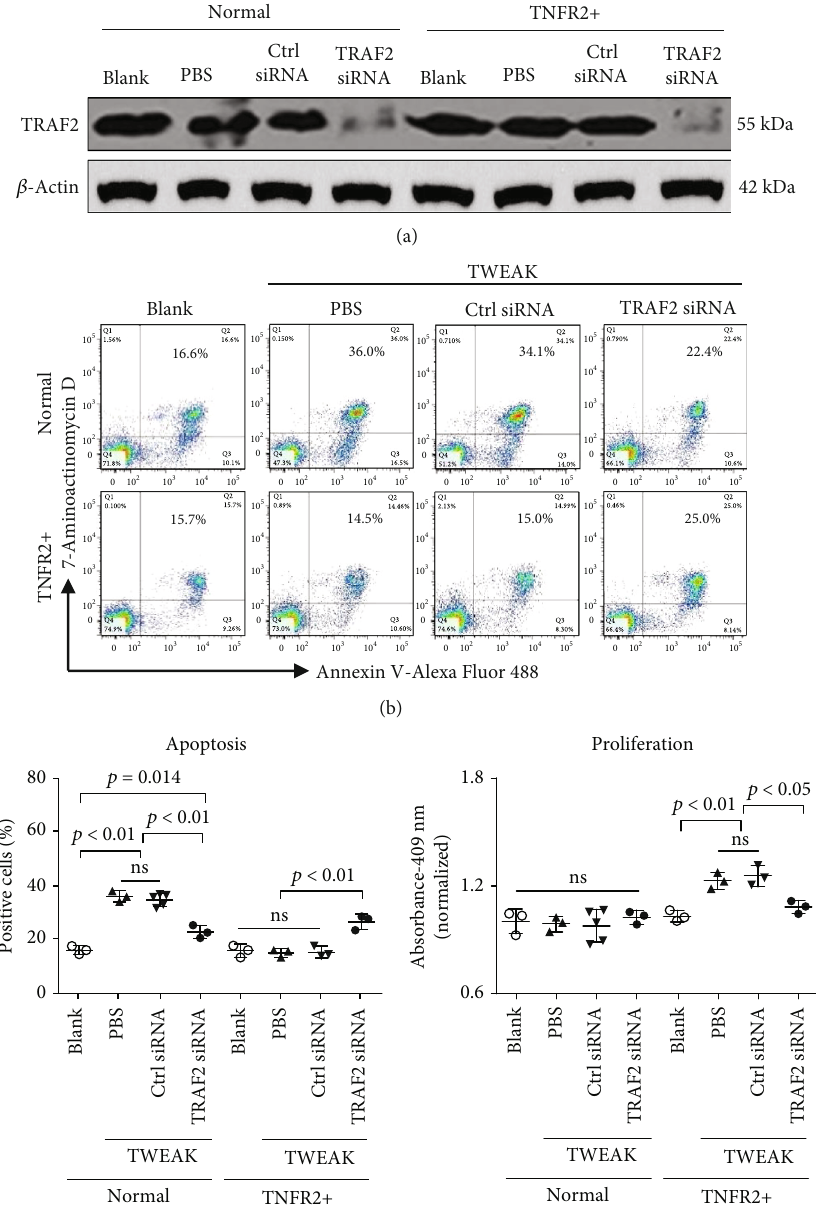
Figure 4: The e ff ect of TRAF2 inhibition on TWEAK-induced cell fates of keratinocytes. Human primary keratinocytes were cultured in vitro and received 48h stimulation with TWEAK (100ng/ml). TNFR2-overexpressing keratinocytes were constructed using a retroviral vector. Some cells were pretransfected with siRNA against TRAF2 or a control target. (a) TRAF2 protein was detected by Western blotting. (b) Apoptotic cells were quanti fi ed by fl ow cytometry. (c) The ratios of apoptotic cells were compared between di ff erent groups. (d) The proliferation of keratinocytes was quantitated by spectrophotometry, followed by comparison across groups. Data were obtained from fi ve independent experiments. Representative images are shown. ns: not signi fi